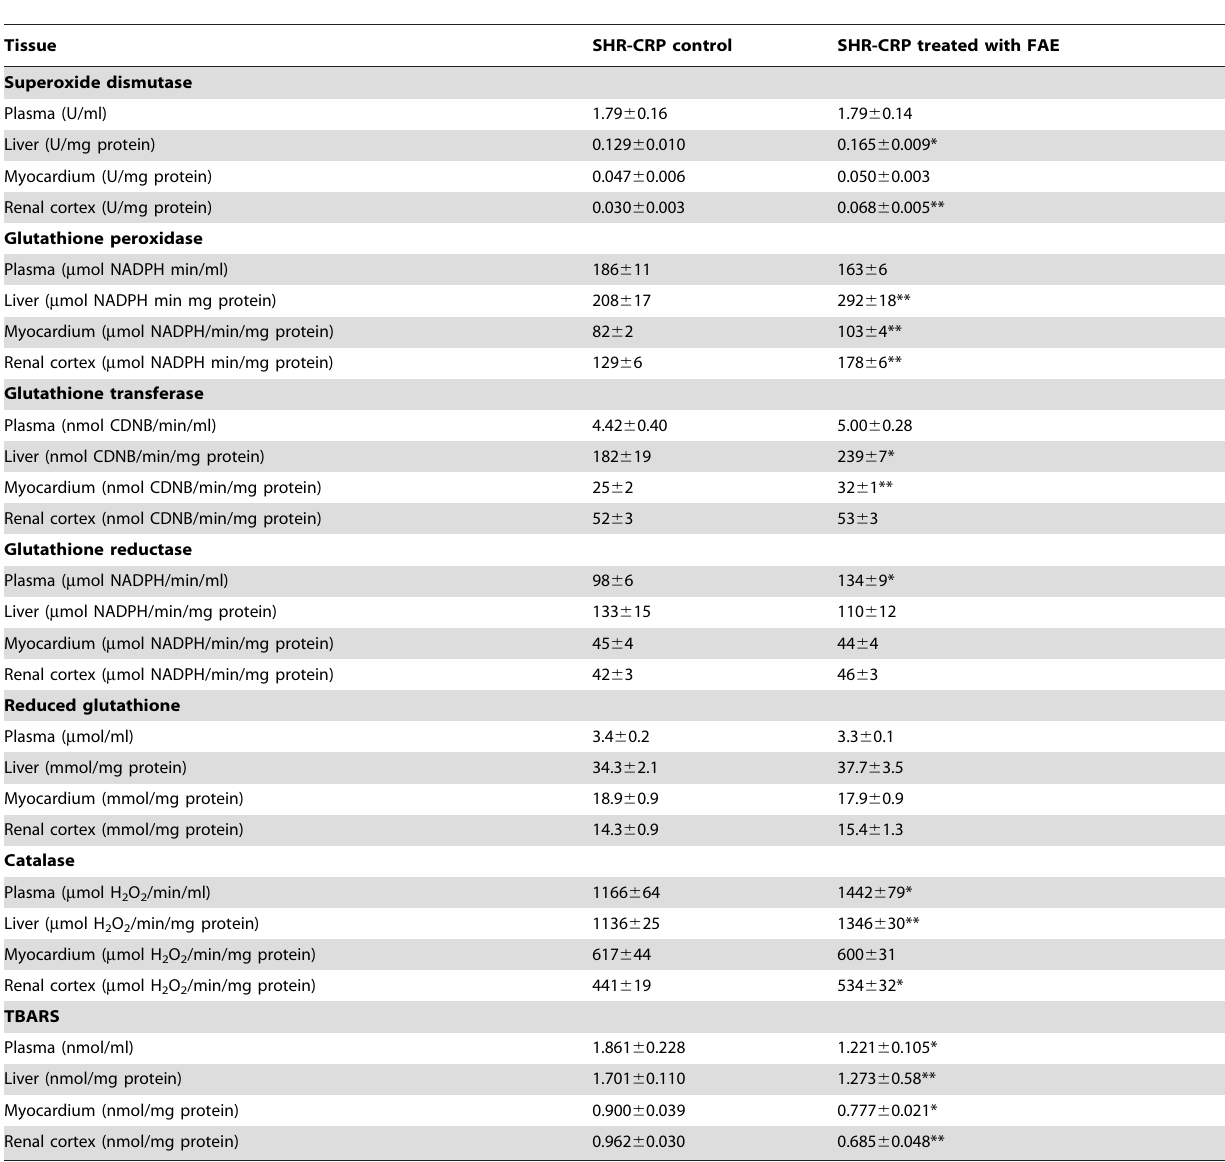
Table 1. Parameters of oxidative stress associated with fumaric acid esters (FAE) treatment.